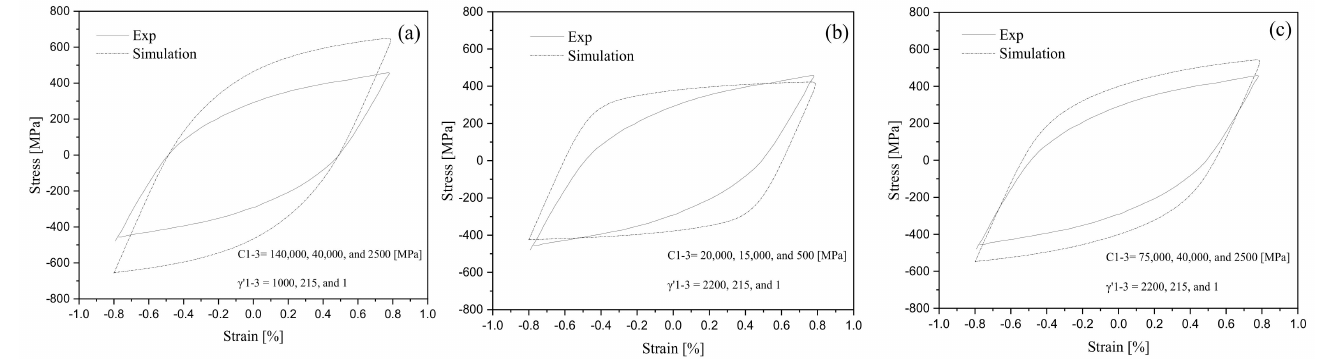
Figure 6. Coefficients C 1 − 3 and γ (cid:48) 1 − 3 achieved a close agreement between the stress-strain hysteresis loop obtained from a test conducted under the strain-controlled condition and the one simulated through FE analysis [25]. ( a – c ) the strain-based hysteresis loops for different sets of C 1 − 3 and γ (cid:48) 1 − 3